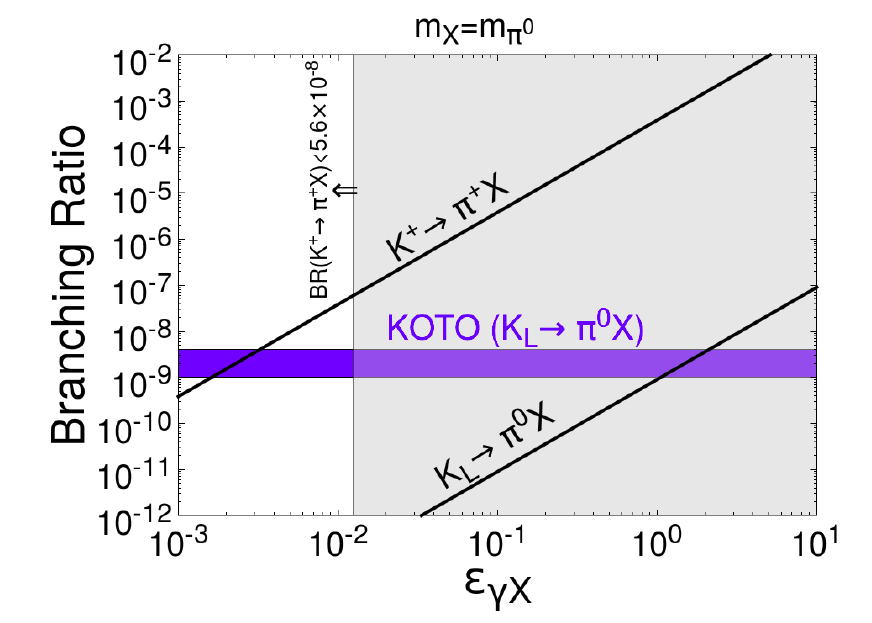
Figure 1. The Br( K boson and photon. The purple band shows the 1 (cid:27) region for KOTO event excess. The gray region is excluded by E949 with Br( K +